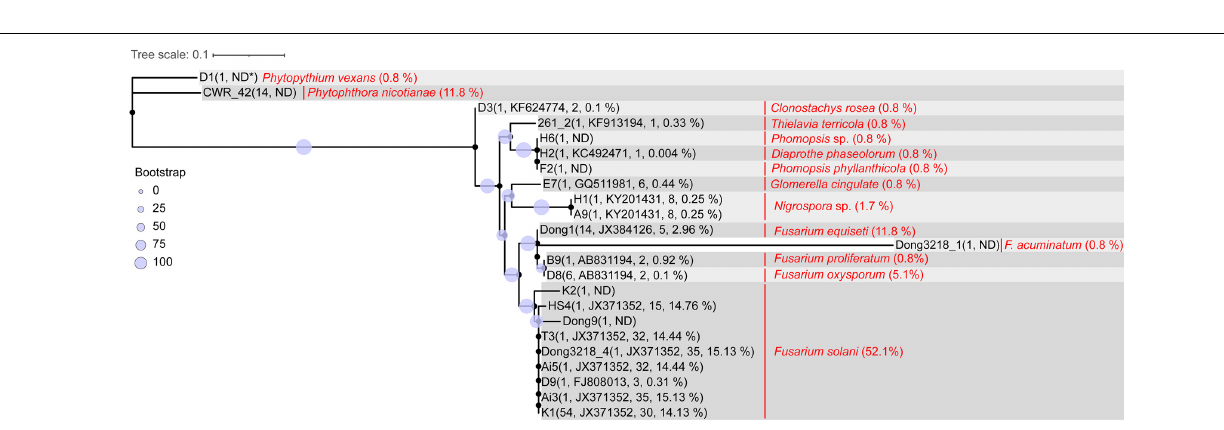
FIGURE 3 | Sequence comparison of ITS1 region between isolated roselle wilt pathogens and rhizosphere amplicons. Parentheses following the strain ID indicate number of representative sequences, blasted most abundant OTU_ID, number of OTUs blasted, and sum of abundance (average percentage of the 60 samples). Words in red denote the species name of the isolate strain ID and parentheses indicate the percentage in 119 isolated strains. The maximum likelihood phylogeny was computed using IQ-TREE (v1.6.12) with the TNe + G4 model and 1000 bootstraps. A consensus tree was visualized and edited in iTOL (v4). (ND ∗ : the ITS sequences did not blast to any OTU amplicon